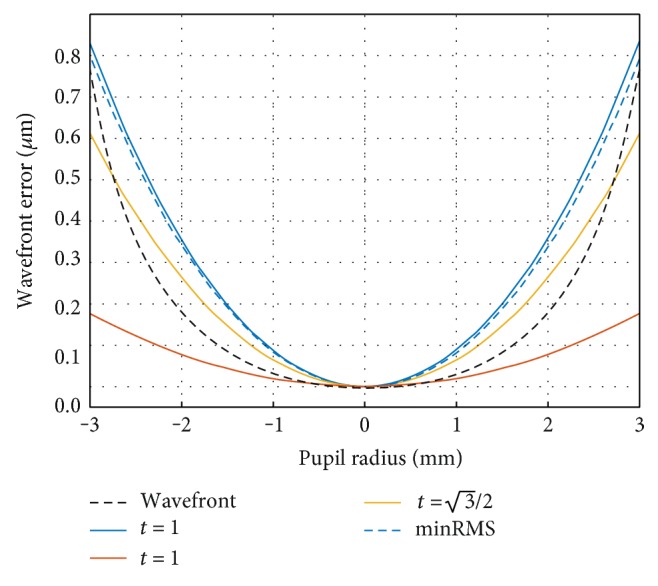
Example profiles of spherical and paraboloid fits (dashed blue line: minRMS; red line: t = 0; blue line: t = 1; orange line: t=3/2) to radially symmetrical wavefront (represented by the black dotted line, where C20 = 0.220 μm, C40 = 0.050 μm, C60 = 0.0025 μm, and r0 = 3 mm).